Question: Write the caption for this figure.
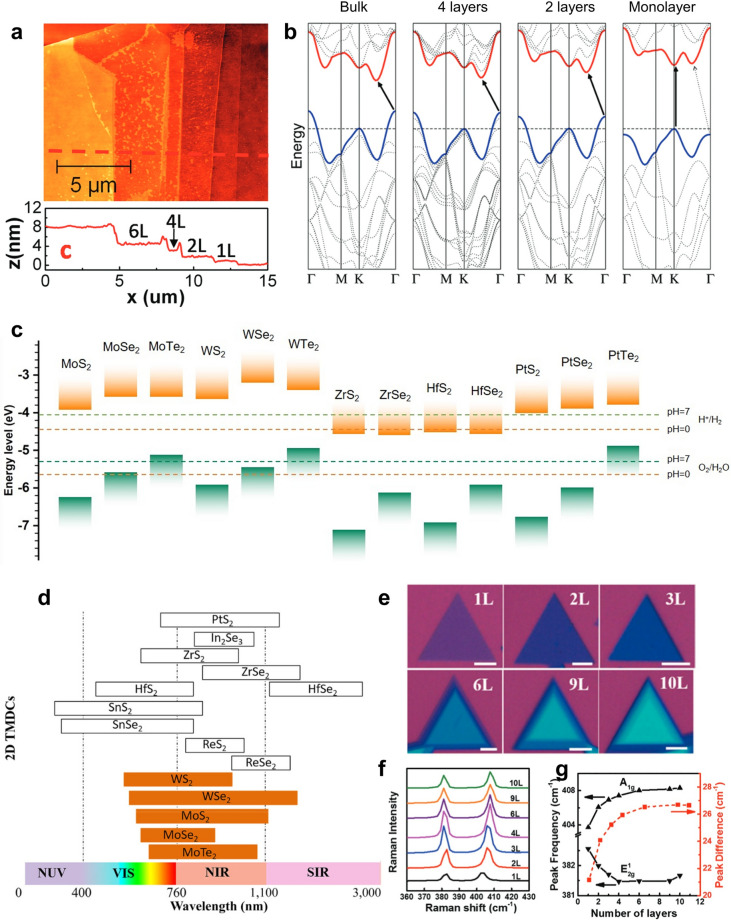
Answer: a Atomic force microscope (AFM) image of the exfoliated MoS 2 sample; b calculated band structures of MoS 2 with different layers [ 24 ]. Copyright 2010 American Chemical Society. c VBM and CBM positions of TMDs monolayers calculated by DFT method. The vacuum level is zero used as reference. Data collected from Ref. [ 73 ]. Copyright 2013 American Chemical Society. d Spectral responses of 2D TMDCs. NUV, VIS, NIR, and LIR represent near ultraviolet, visible, near infrared, and longwave infrared, respectively [ 75 ]. Copyright 2020 Springer Nature. e Optical images of MoS 2 flakes with different layers on Si substrate; f Raman spectra of the MoS 2 flakes with different layers. g Peak frequency variation of E 2g 1 and A 1g Raman mode and their difference [ 76 ]. Copyright 2017 Wiley-VCH